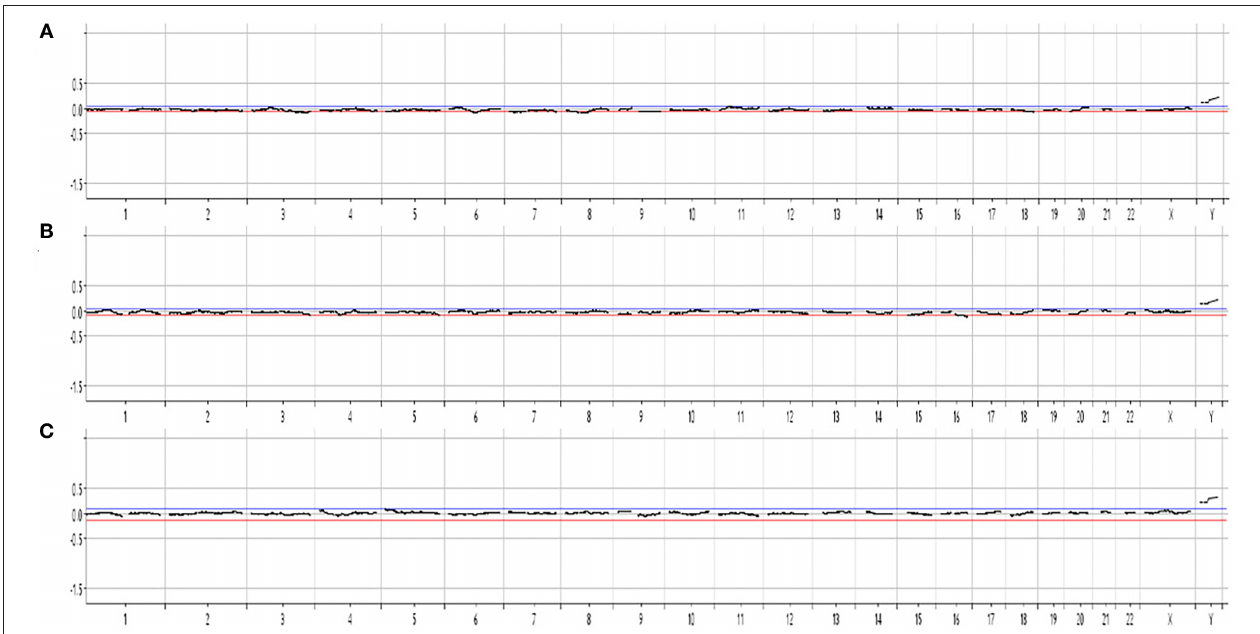
FIGURE 2 | Cell-based NIPT chromosomal microarray of single-cell whole genome amplified DNA from three fetal extravillous trophoblasts (A–C) . The result is consistent with a normal female karyotype,